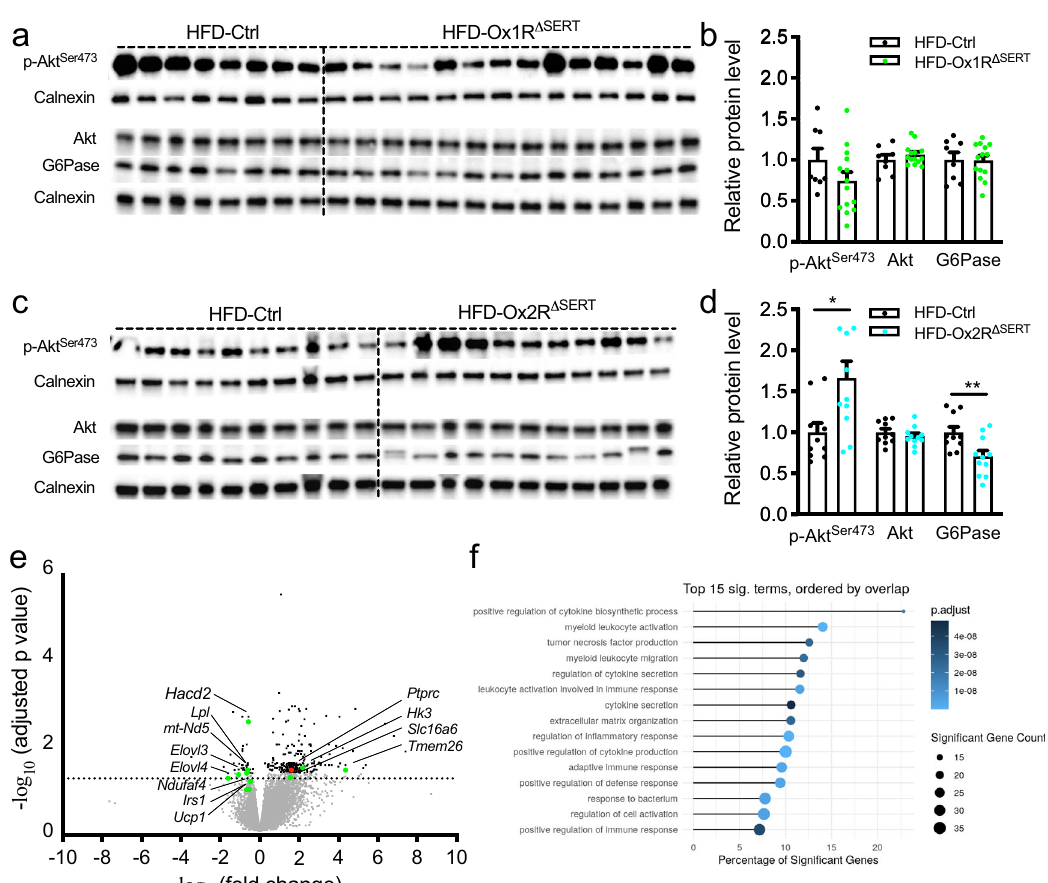
Fig. 6 Insulin signaling in liver and BAT in obese Ox1R Δ SERT and Ox2R Δ SERT mice. a , b Western blot images and quanti fi cation of p-Akt Ser473 , Akt, and G6Pase protein in the liver of control and Ox1R Δ SERT mice. HFD-Ctrl, n = 8; HFD-Ox1R Δ SERT , n = 14. c , d Western blot images and quanti fi cation of p-Akt Ser473 , Akt, and G6Pase protein in the liver of control and Ox2R Δ SERT mice. HFD-Ctrl, n = 10; HFD-Ox2R Δ SERT , n = 11. p = 0.013 (p-Akt Ser473 ) and 0.0085 (G6Pase). Data are represented as means± SEM. * p < 0.05, ** p < 0.01; as determined by unpaired two-tailed Student ’ s t -test. e Volcano plot of differential expression analysis of RNA sequencing of BAT in Ox1R Δ SERT mice, compared to control mice. Some genes of interest are annotated. The differential gene expression test was done using negative binomial generalized linear models implemented in DESeq2 1.26.0. P -values are false discovery rates adjusted using the Benjamini-Hochberg procedure. f Top 15 differentially regulated gene ontology (GO) terms of class biological process in BAT of Ox1R Δ SERT mice, compared to control mice. Signi fi cance is mapped to color, the dot size represents the number of signi fi cant genes in the GO term and the x -axis maps the percentage of signi fi cant genes to the overall gene GO term size. Gene-ontology term analysis of the 265 differentially expressed genes was carried out using the clusterPro fi ler R package, which utilizes an over-representation analysis calculating p -values by hypergeomtric distributions. P -values are FDR-adjusted. n = 4. Source data are provided as a Source Data fi